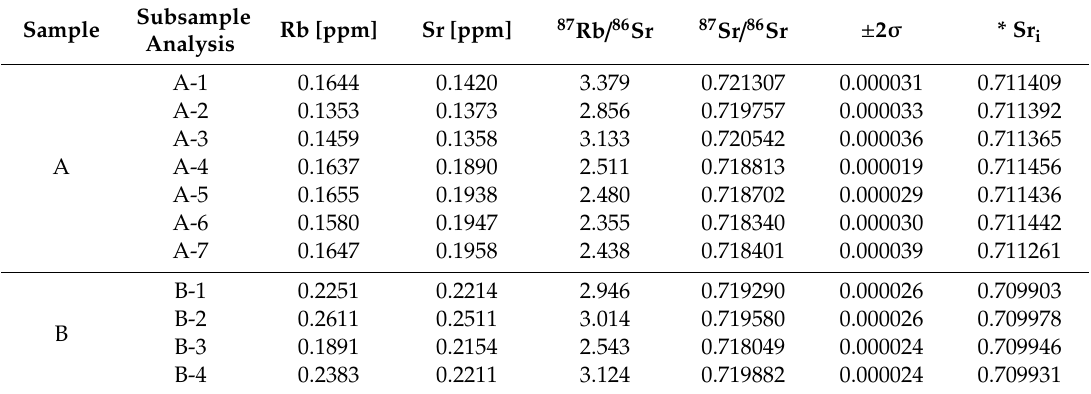
Table 2. Lead isotope data for the pyrite sub-samples from specimens A and B in this study.